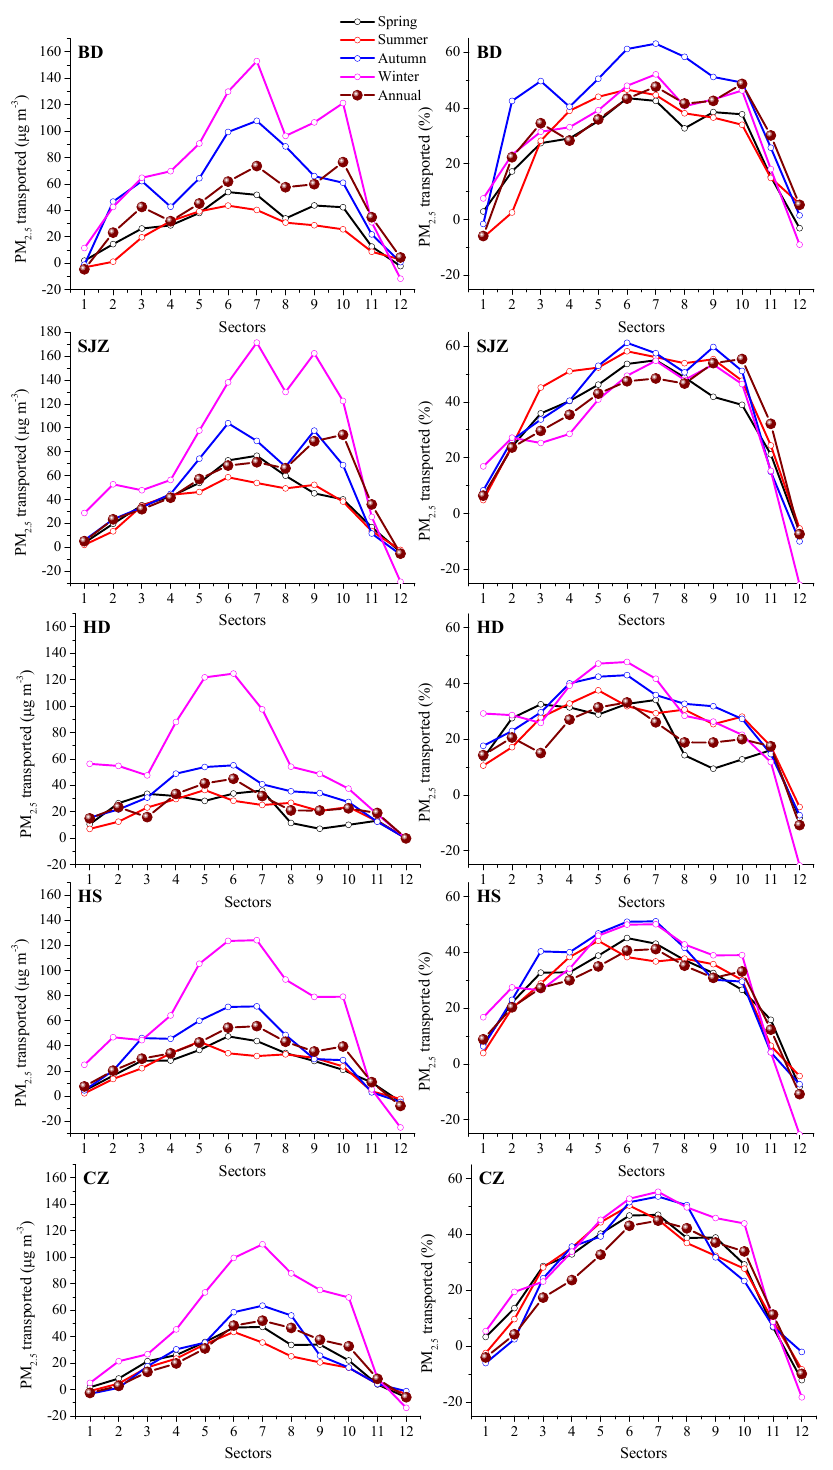
Figure 12. Annual and seasonal transported concentration and percentage of each sector for PM 2.5 in five cities during 2013–2015.